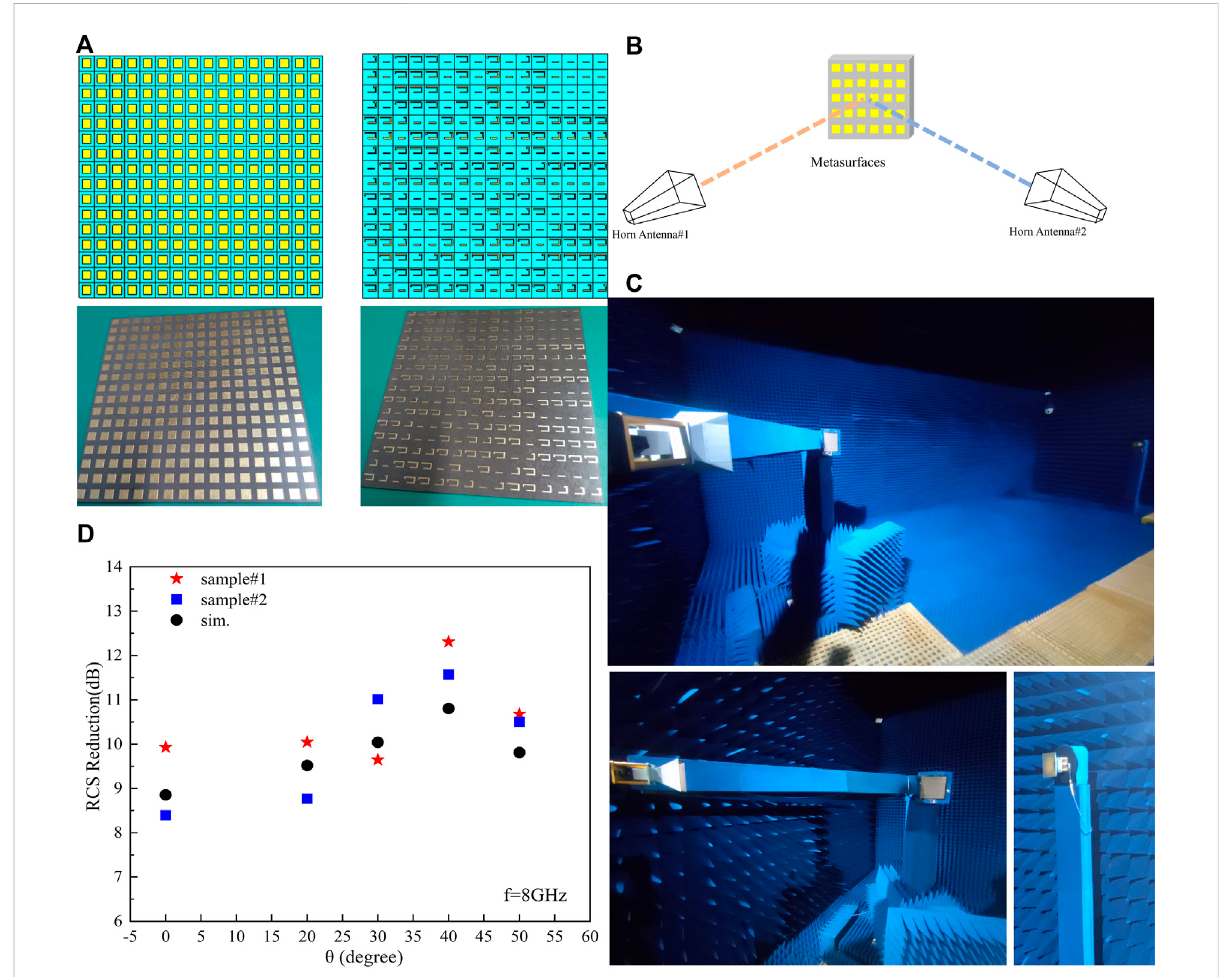
FIGURE 6 (A) Front and back view of the prototype and simulated model. (B) Schematic diagram of the bistatic RCS measured method. (C) Experimental environment of bistatic RCS measurement. (D) Results of RCS reduction in mirror direction of the simulated models, sample 1 and sample